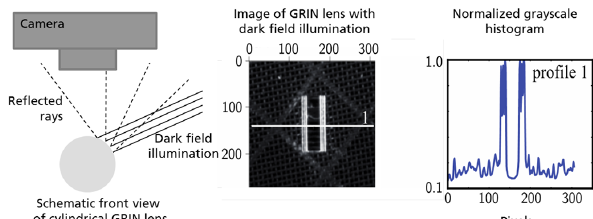
Figure 10. The center image shows the enhanced contrast achieved through dark field lighting. The right diagram presents a corre- sponding normalized intensity profile. The left drawing explains the separation of blobs using dark field illumination on a cylindrical lens (only one direction of illumination is illustrated): only the rays hitting a specific region of the cylindrical surface will be reflected into the camera. This phenomenon occurs on both sides of the GRIN lens so that there are two separated blobs in image processing.